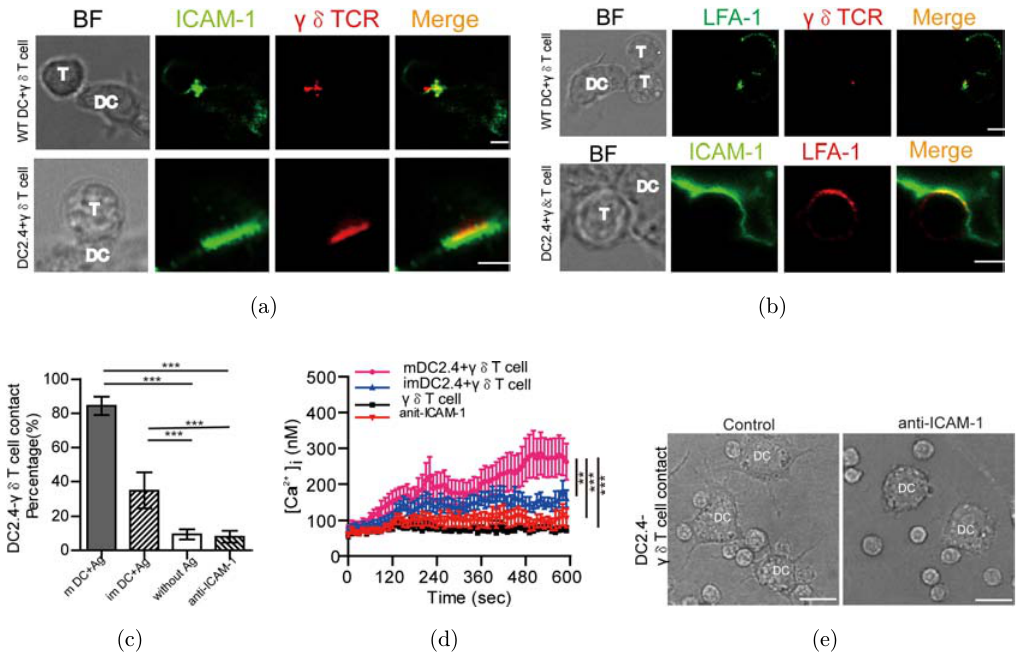
Fig. 4. The interaction between (cid:1)(cid:2) T cells and DCs. (a) The location of ICAM-1 and (cid:1)(cid:2) TCR at the interface between the DCs and (cid:1)(cid:2) T cells. The upper line indicates the interaction between wild-type (WT) DCs and (cid:1)(cid:2) T cells, and the (cid:1)(cid:2) T cells were labeled with PE-conjugated (cid:1)(cid:2) TCR antibody (red), and DCs were labeled with APC-conjugated ICAM-1 antibody (green). The bottom line indicates the interaction between an ICAM-1-EGFP/DC2.4 cell and a (cid:1)(cid:2) T-cell. The (cid:1)(cid:2) T cells were labeled with PE-conjugated (cid:1)(cid:2) TCR antibody (red). (b) The location of LFA-1 at the interface between the DCs and (cid:1)(cid:2) T cells. A (cid:1)(cid:2) T-cell interacts with a WT DC labeled with FITC-conjugated LFA-1 antibody (green) and PE-conjugated (cid:1)(cid:2) TCR antibody (red). A (cid:1)(cid:2) T-cell interacts with an ICAM-1-EGFP/DC2.4 cell (this cell line is a gift from professor Yiwei chu, 40 Fudan university, Shanghai, China) labeled with PE- conjugated LFA-1 antibody (red); the ICAM-1 on the DC 2.4 cell line is labeled with EGFP (green). The upper line indicates the interaction between a WT DC and a (cid:1)(cid:2) T-cell, and the bottom line indicates the interaction between an ICAM-1-EGFP/DC2.4 cell and a (cid:1)(cid:2) T-cell. (c) The amount of interaction between mature DC2.4 cell and (cid:1)(cid:2) T cells and between immature DC2.4 cell and (cid:1)(cid:2) T cells. The amount of interaction between DC2.4 cell and (cid:1)(cid:2) T cells, without antigen. The amount of interaction between (cid:1)(cid:2) T cells and DC2.4 cell with ani-ICAM-1 antibody pretreated. (d) Calcium signaling released in (cid:1)(cid:2) T cells interacting with mature DC2.4 cells, immature DC2.4 cells or pretreated DC2.4 cells. Data are expressed as mean (cid:4) s.e.m.; (cid:5)(cid:5) p < 0 : 01, (cid:5)(cid:5)(cid:5) p < 0 : 001 (two-tailed Student t -test). Scale bar ¼ 2 (cid:3) m. (e) The contact of DC- (cid:1)(cid:2) T cell with or without anti-ICAM-1 antibody treatment. Scale bar ¼ 10 (cid:3)